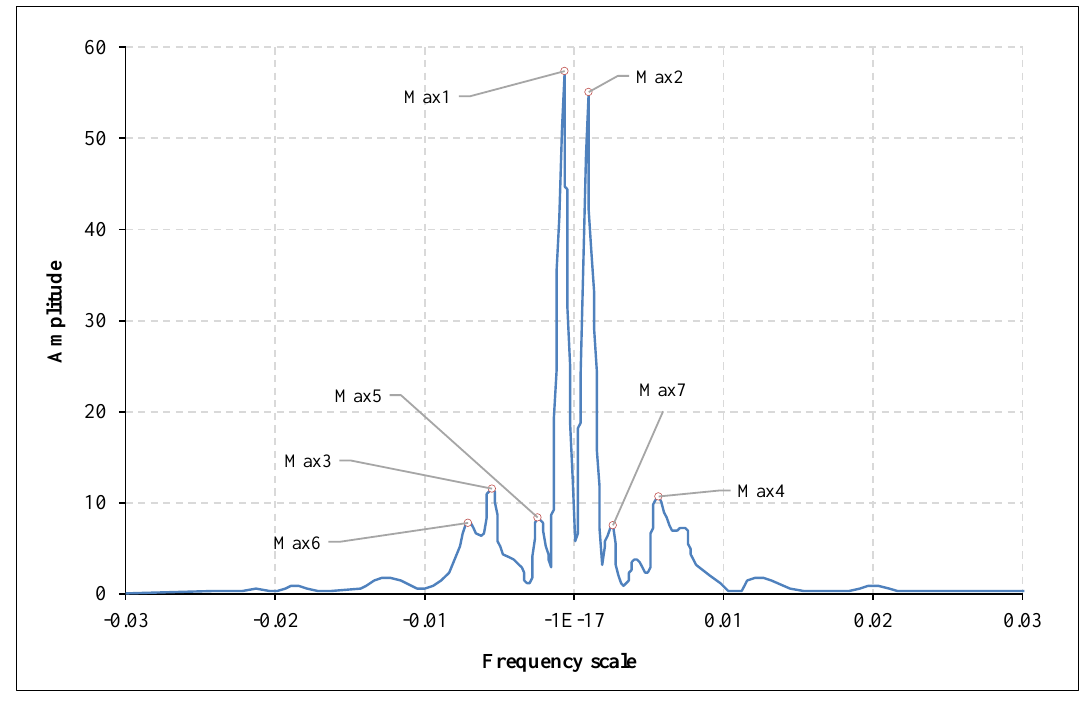
Figure 13. Amplitude spectrum of Fourier